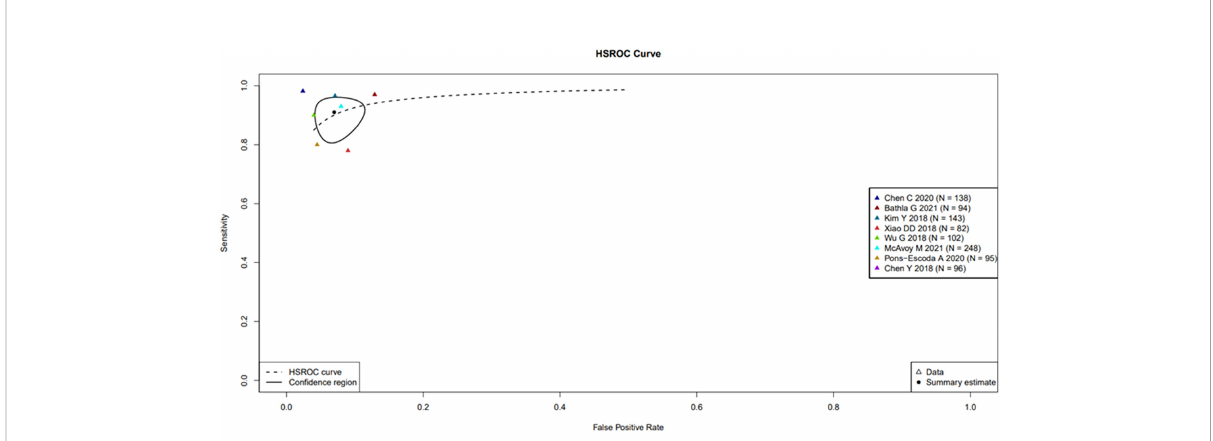
FIGURE 3 Hierarchical Summary Receiver Operator Curve (HSROC) plot displaying the diagnostic performance of radiomic based ML tools & DL tools in differentiating PCNSL from GBM. Each coloured triangle represents each of the studies in the meta- analysis. The plotted curve is the regression line that summarizes the overall diagnostic accuracy. The pooled sensitivity and speci fi city estimate is based on the assumption of conditional independence and the use of perfect reference standards. The “ TP ” , “ FP ” , “ FN ” , “ TN ” rates for the two studies (Park JE 2020 and Shrot S 2019 studies) as the former study has no available accuracy value and the latter one has both sensitivity and speci fi city equal to one.